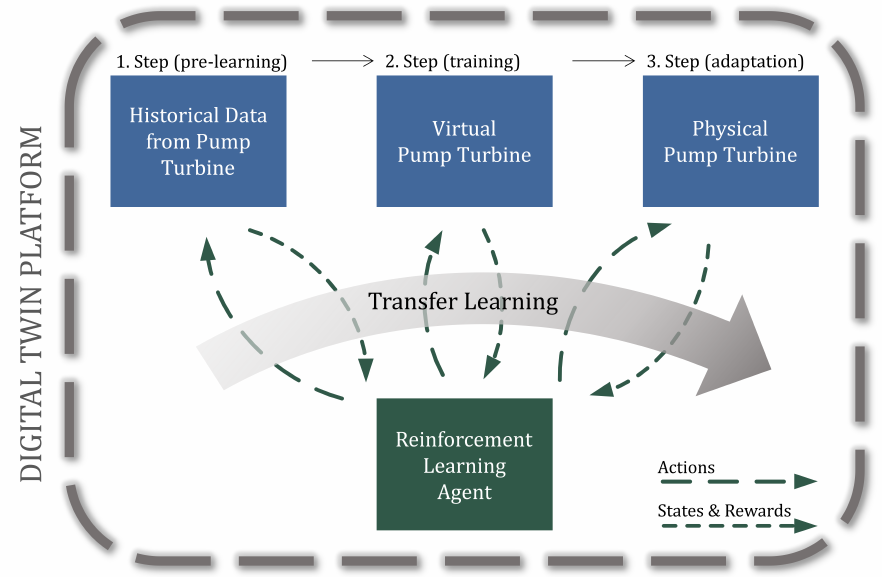
Figure 2. Concept of the application of RL on a digital twin (DT)